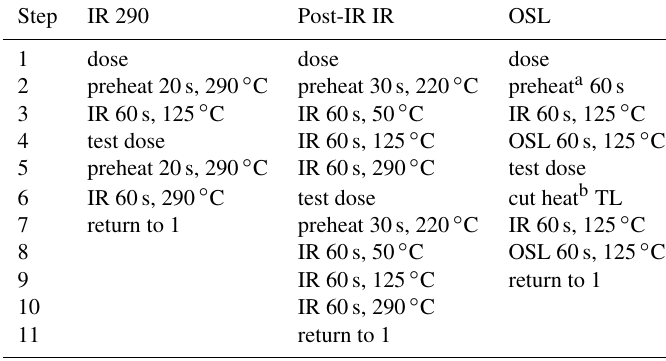
Table A3. Measurement steps used for IR 290, post-IR IR and OSL dating. Step